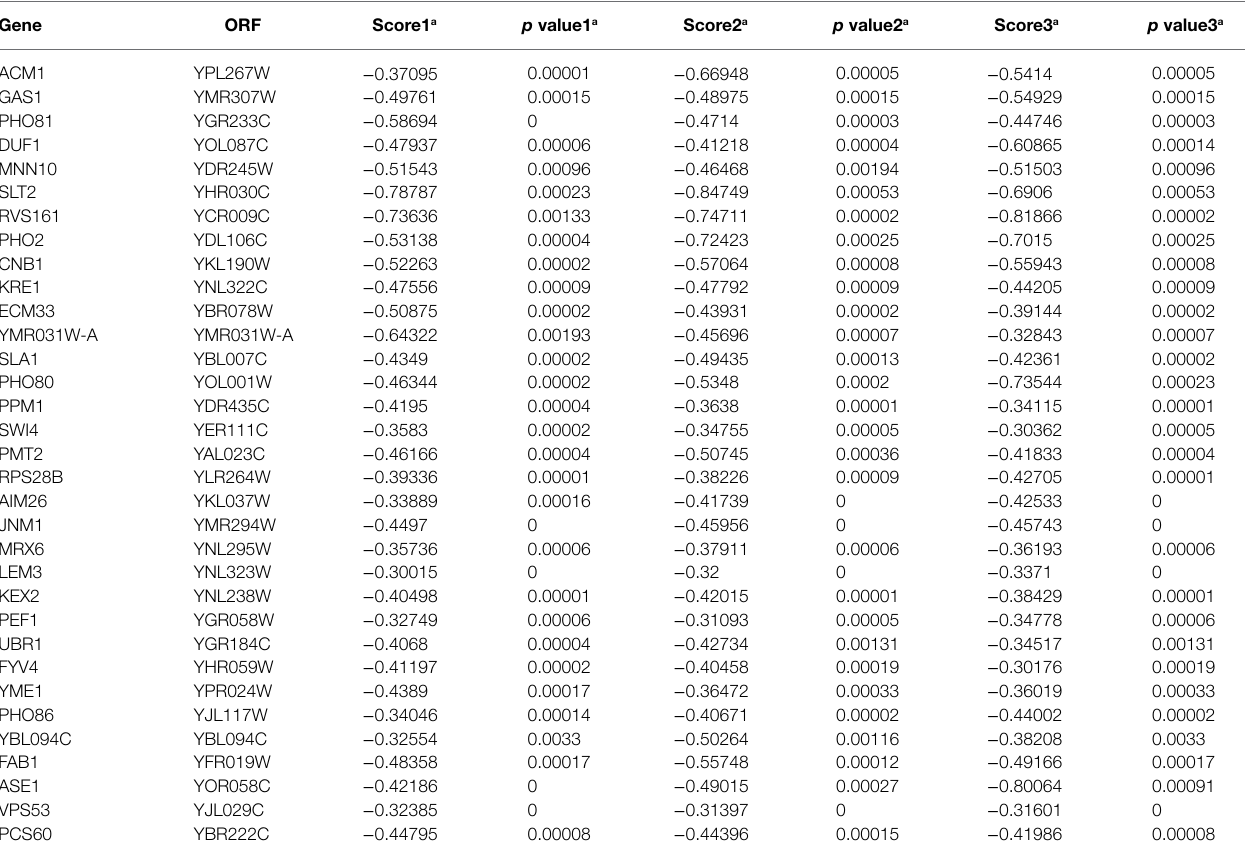
TABLE 1 | Genome-wide screening results of 33 selected NaHCO 3 -sensitive mutants.